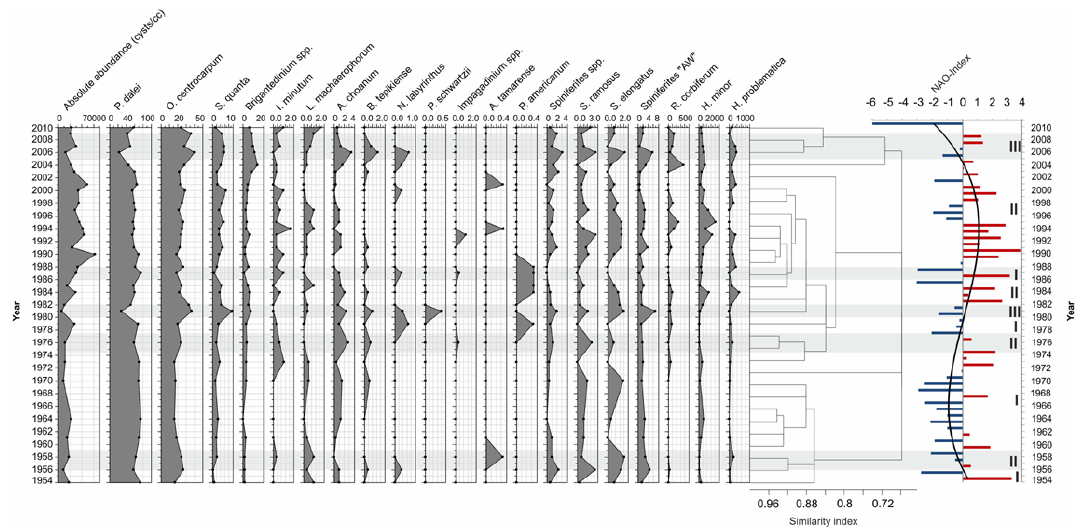
Fig. 7. Cyst assemblages in MC S4-1 and associated groups according to cluster analysis; cyst concentrations and Chlorophycean and Prasinophyceae algae are given in nbcm − 3 , relative dinocyst abundances are given in %; the NAO index is shown to the right (Hurrell,